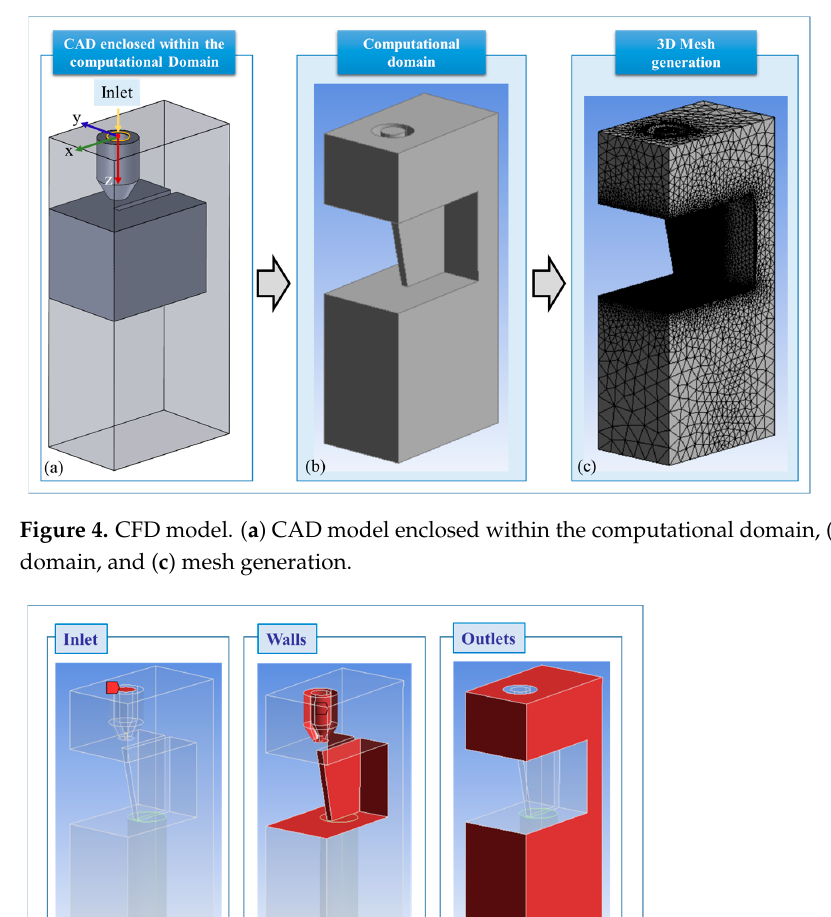
10 of 24 Table 2. Coefficients for the adopted turbulence models. Coefficients